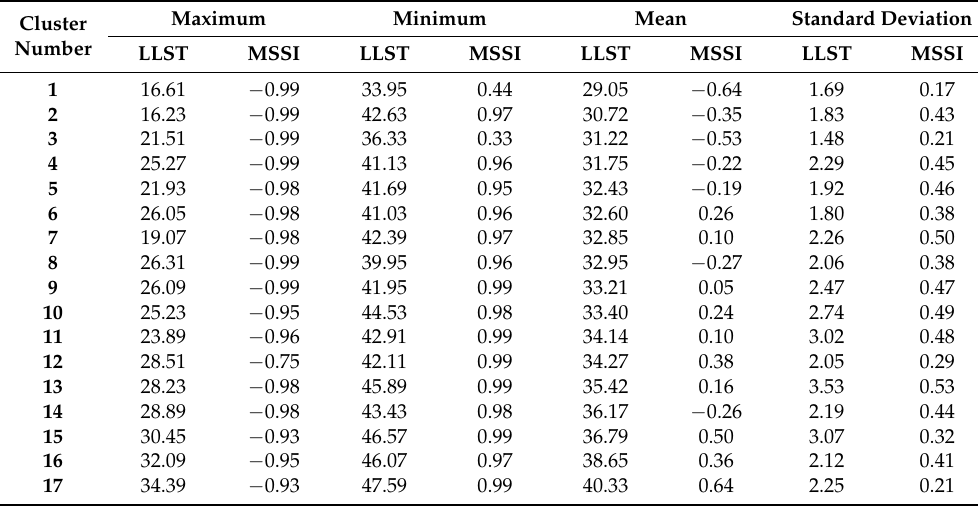
and represent the LLST and Figure 13. The time series centroids of all 17 clusters. Figure 13. The time series centroids of all 17 clusters. 2002 L and 2002 M represent the LLST and MSSI MSSI of the year 2002, and so on. 2002 𝐿𝐿 2002 𝑀𝑀 of the year 2002, and so on. Table 5. The statistical summary of Table 5. The statistical summary of k - c 𝑘𝑘